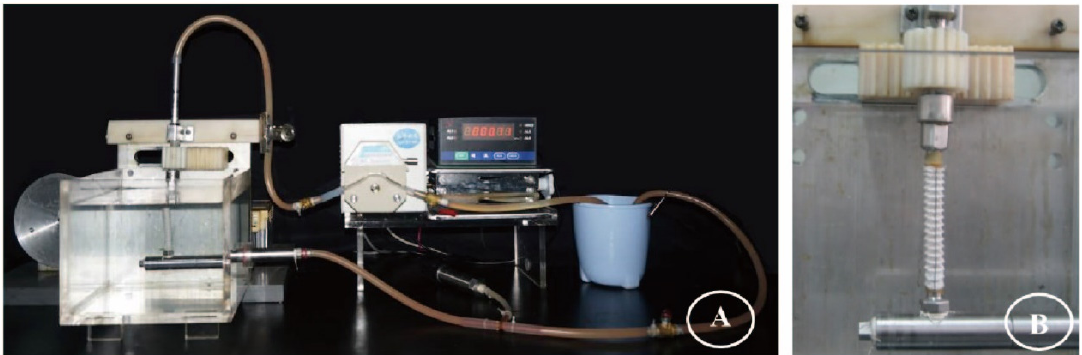
Figure 17. The fatigue machine developed at Donghua University simulates the twisting observed for stent ‐ grafts in vivo . It mimics the pulsatile dynamics within human tortuous iliac arteries ( A ). The device is attached by its first extremity to a fixed vertical metallic pipe. The second extremity is attached to an upper metallic vertical pipe, which can be rotated clockwise and anticlockwise to cause repeated twisting of the stent ‐ graft ( B ). Distilled water is circulated from the reservoir to the vertical metallic tube through an electronic pulsatile pump. After passing through the stent ‐ graft (lined with an impervious latex membrane), the pressure and volumetric rate of the water flow is regulated and returned to the reservoir. The temperature in the basin is maintained at 37 °C.